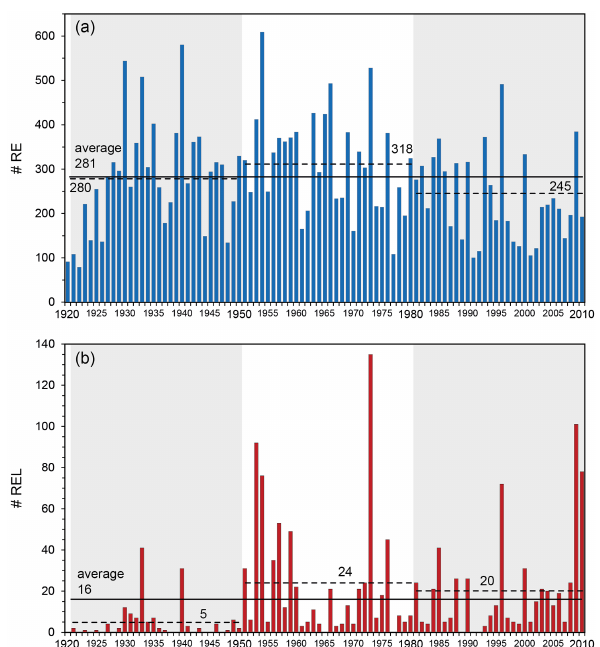
Figure 3. (a) Number of rainfall events (RE) and (b) number of rainfall events with landslides (REL) per year in Calabria in the 90- year period 1921–2010. Solid lines show average values for the 90- year period. Dashed lines show average values for the three 30-year periods 1921–1950, 1951–1980, and 1981–2010.